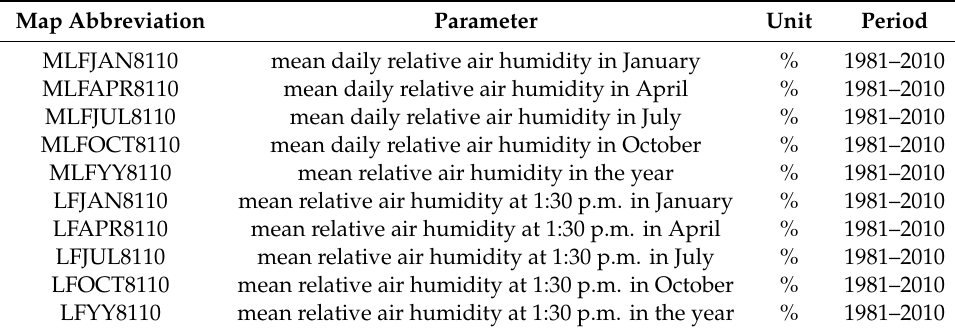
Figure 2. Mean daily relative air humidity at 1:30 p.m. in January (left) and July (high) in the period 1981–2010. Table 4. Resulting maps of relative air humidity.